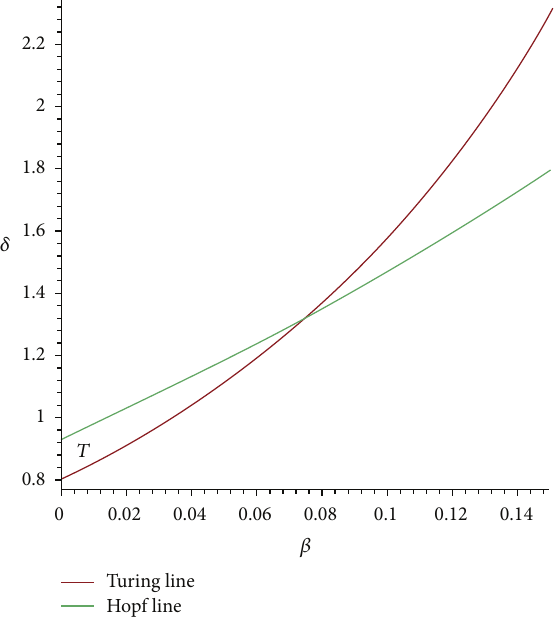
Figure 1: Bifurcation diagram for the systems (4a) and (4b). The greenoneistheHopfbifurcationcriticallineandtheredone,Turing bifurcation critical line. The figure shows the Turing space which is marked by 𝑇 . Parameters values: 𝛾 = 1.5 and 𝜀 = 0.15